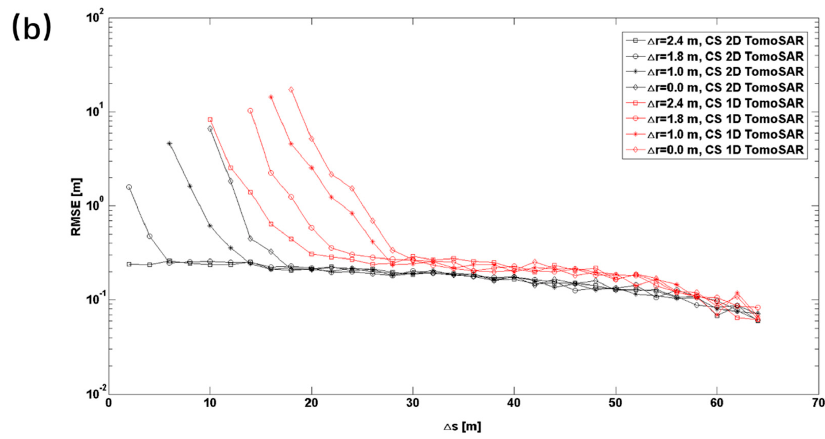
Figure 9. Estimation accuracy of the distance between two scatterers as function of ( a ) ∆ r at ∆ s of 0, 6, 10, and 30 m, and ( b ) ∆ s at ∆ r = 0, 1, 1.8, and 2.4 m.